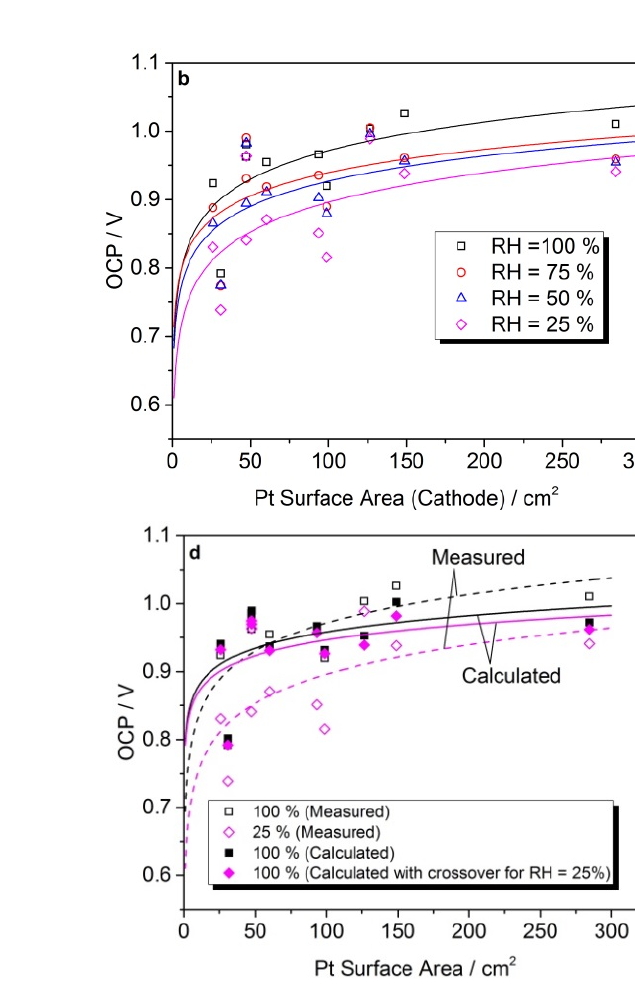
Figure 6. ( a ) H 2 crossover current normalised by Pt surface area vs. Pt surface area for all 4 RH values tested, ( b ) OCP vs. Pt surface area at the cathode for all RH values, ( c ) average H 2 crossover current vs. RH and ( d ) the measured and calculated dependency of OCP on Pt surface area for RH values of 100% and 25%. The calculated value for 25% is based off the 100% data with the added crossover current of 3.53 mA as per ( c ).